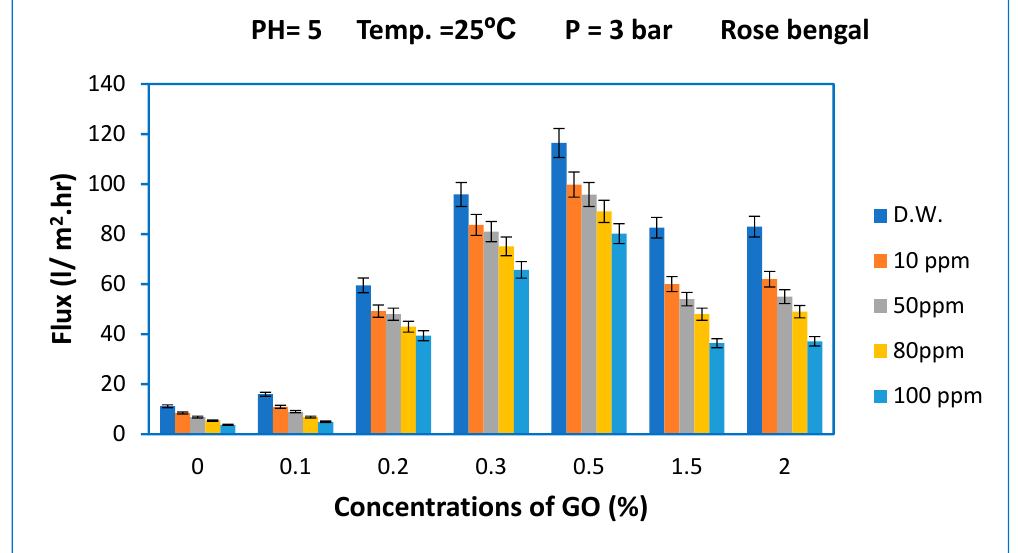
Figure 8. Effect of the Rose Bengal dye concentration in feed solution on the permeation flux of the membrane prepared at different GO concentrations. The bar height is the average of five measurements of permeation flux and the error bars represent ± one standard deviation.